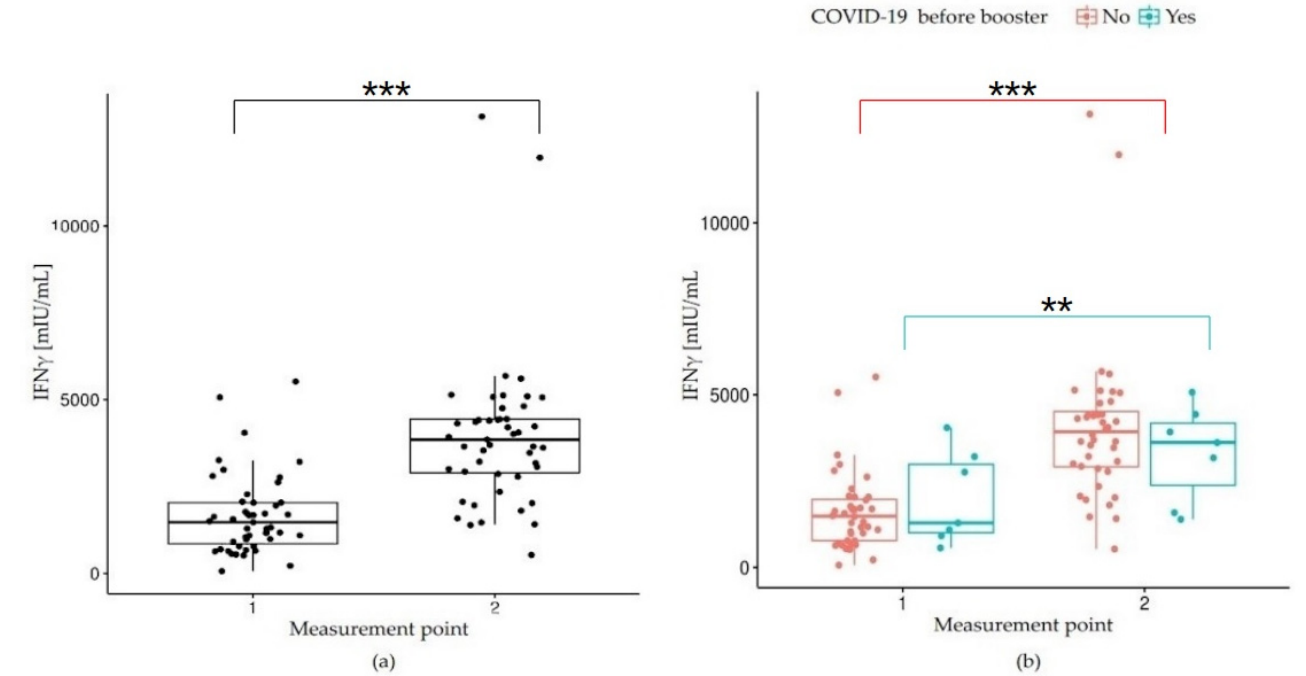
Figure 3. IFN γ concentration (mIU/mL) obtained in IGRA test: ( a ) before the booster (1) and 21 days after (2), p < 0.001; ( b ) before the booster (1) and 21 days after (2) depending on the COVID-19 history before the study start. If a p -value is less than 0.01, it is flagged with 2 stars (**). If a p -value is less than 0.001, it is flagged with three stars (***).